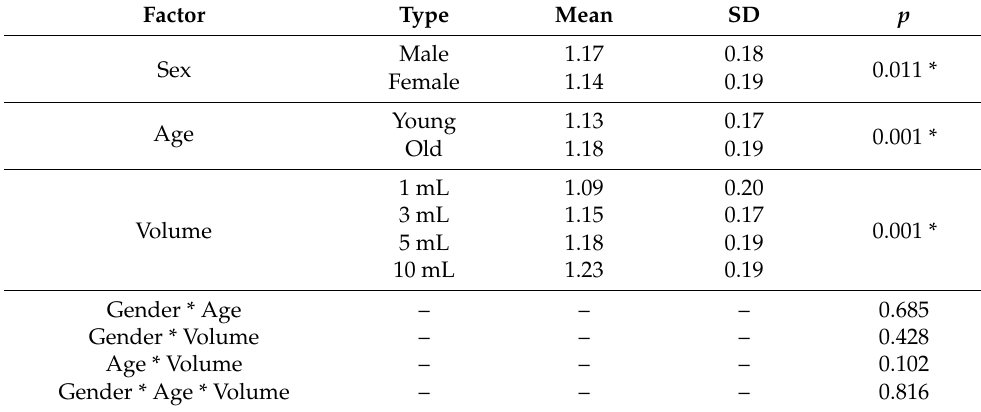
Figure 11. Comparison of the total excursion time of the thyroid cartilage movement T TC1 + TC2 by ( a ) sex and ( b ) age. Table 7. Analysis of variance results of thyroid cartilage total excursion